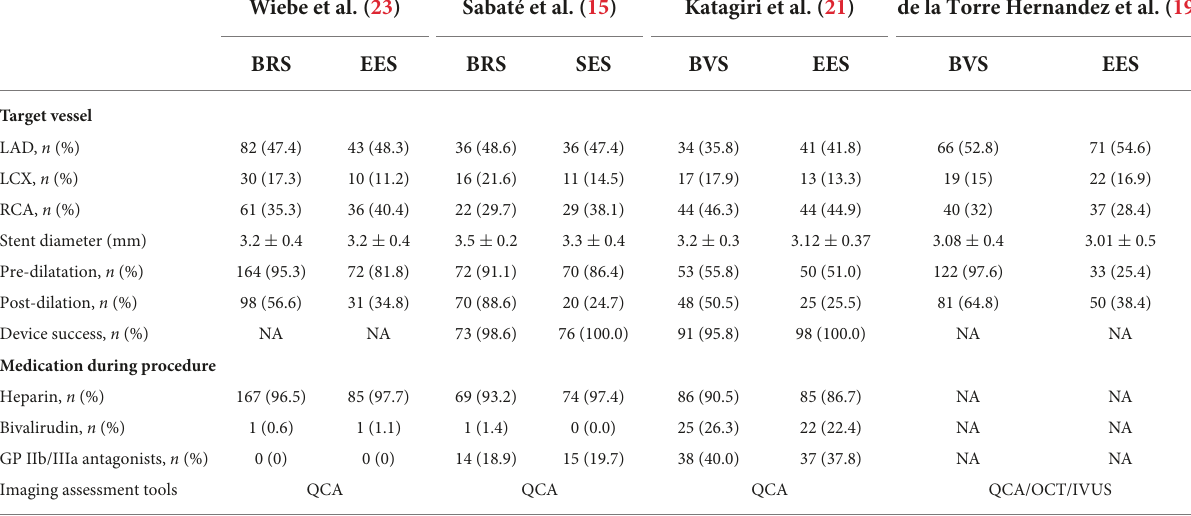
TABLE 3 Lesion and procedural characteristics of included